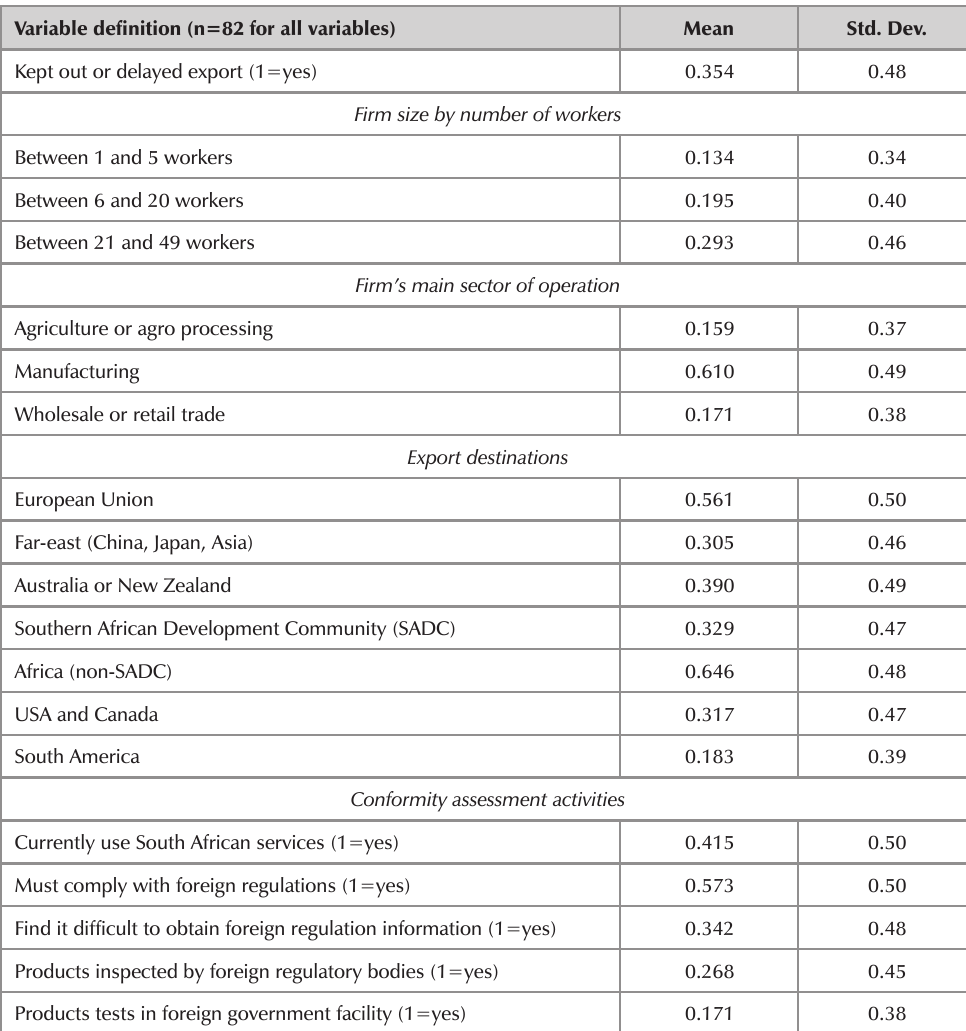
Summary statistics of variables used in